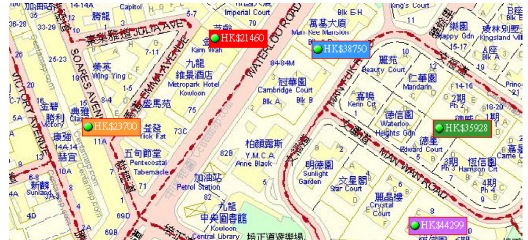
Figure 8. Street block partition (by dashed lines) and